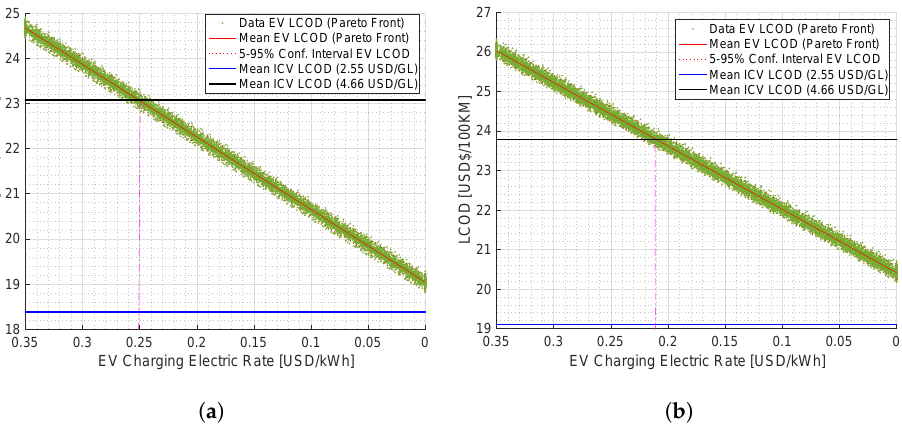
Figure 6. Sensibility Analysis with respect to EV Charging Electric Rate. ( a ) Case A ( r = 10%). ( b ) Case B ( r = 12%).